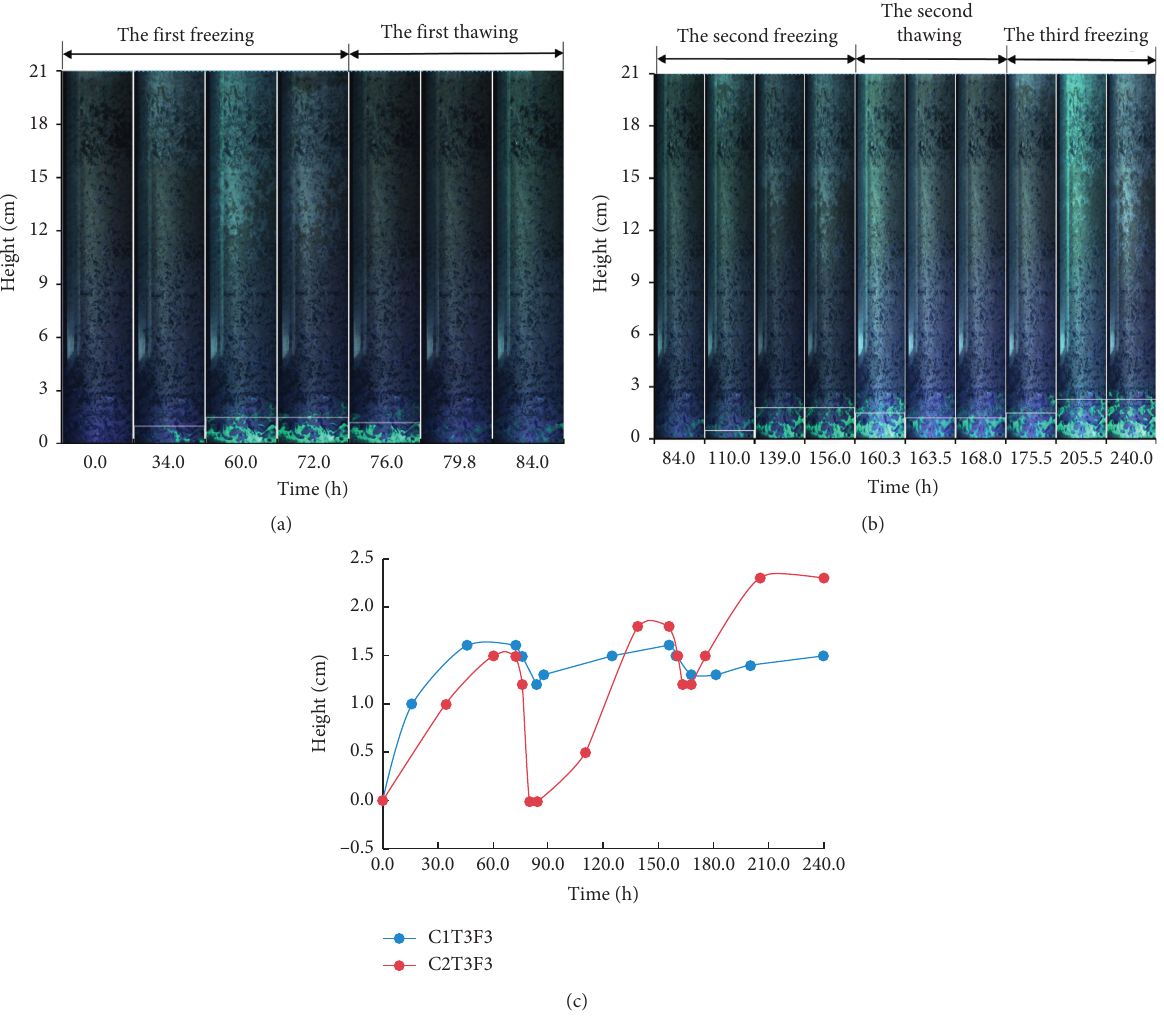
Figure 8: Variation of the migration height traced by fluorescein during the freezing and thawing test. (a) Liquid water height change during the first freezing and thawing. (b) Liquid water height change during the second freezing, second thawing, and third freezing. (c) Liquid water migration height changes during the freezing and thawing cycles of C1T3F3 and